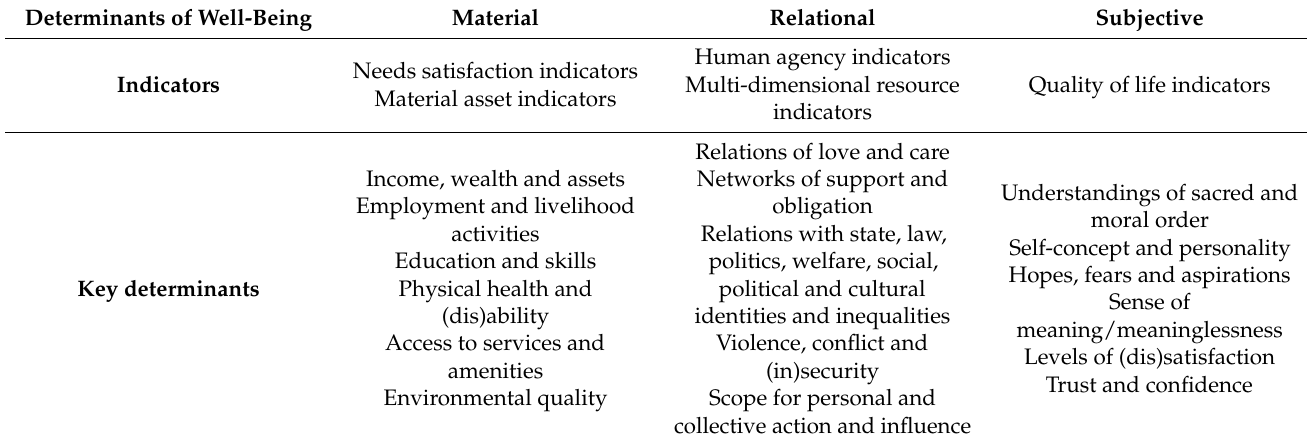
Table 1. Characteristics of well-being